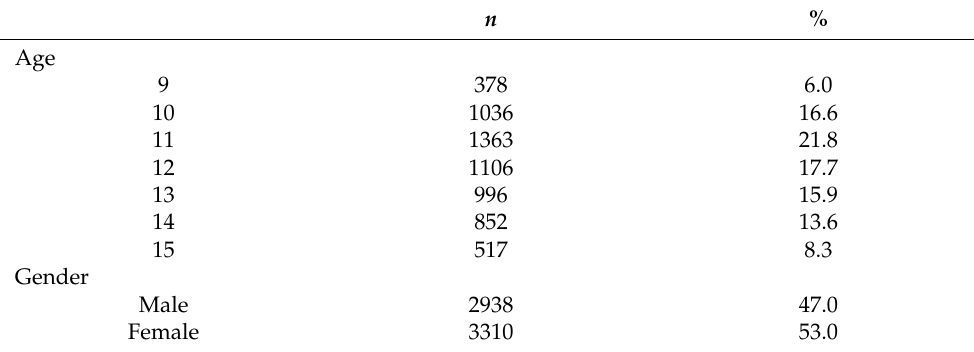
Table 1. Characteristics of participants ( n = 6248).